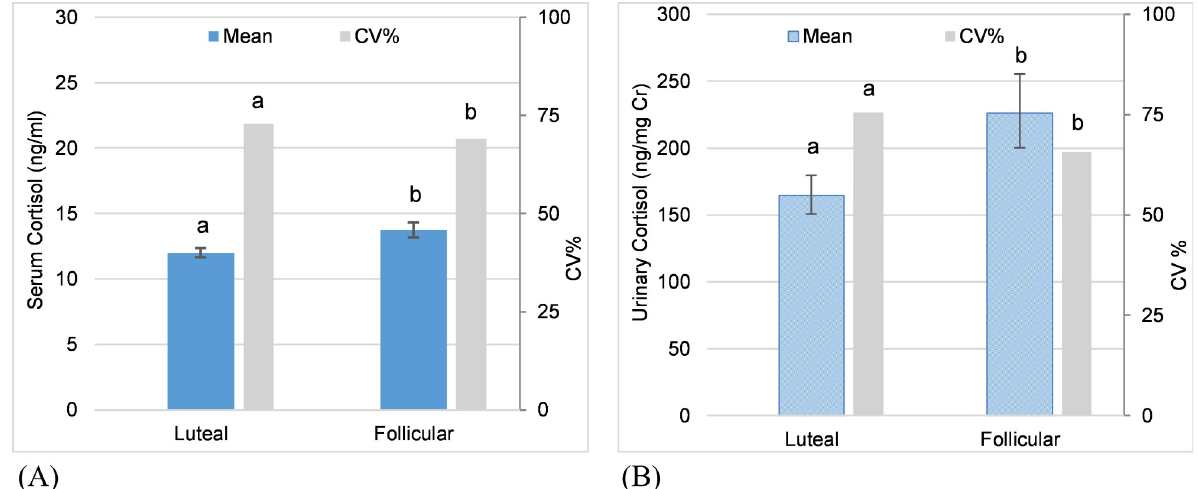
Fig 2. Ovarian cycle phase as a predictor of adrenal GC activity. Predictions from GLMMs for cortisol concentrations comparing mean values between the luteal phase and follicular phase of the ovarian cycle for all elephants combined (error bars represent the standard error of the prediction). Letters denote significant differences in mean values and in coefficients of variation (CVs) between cycle phases. (A) Serum cortisol in all elephants combined. (B) Urinary cortisol in all elephants